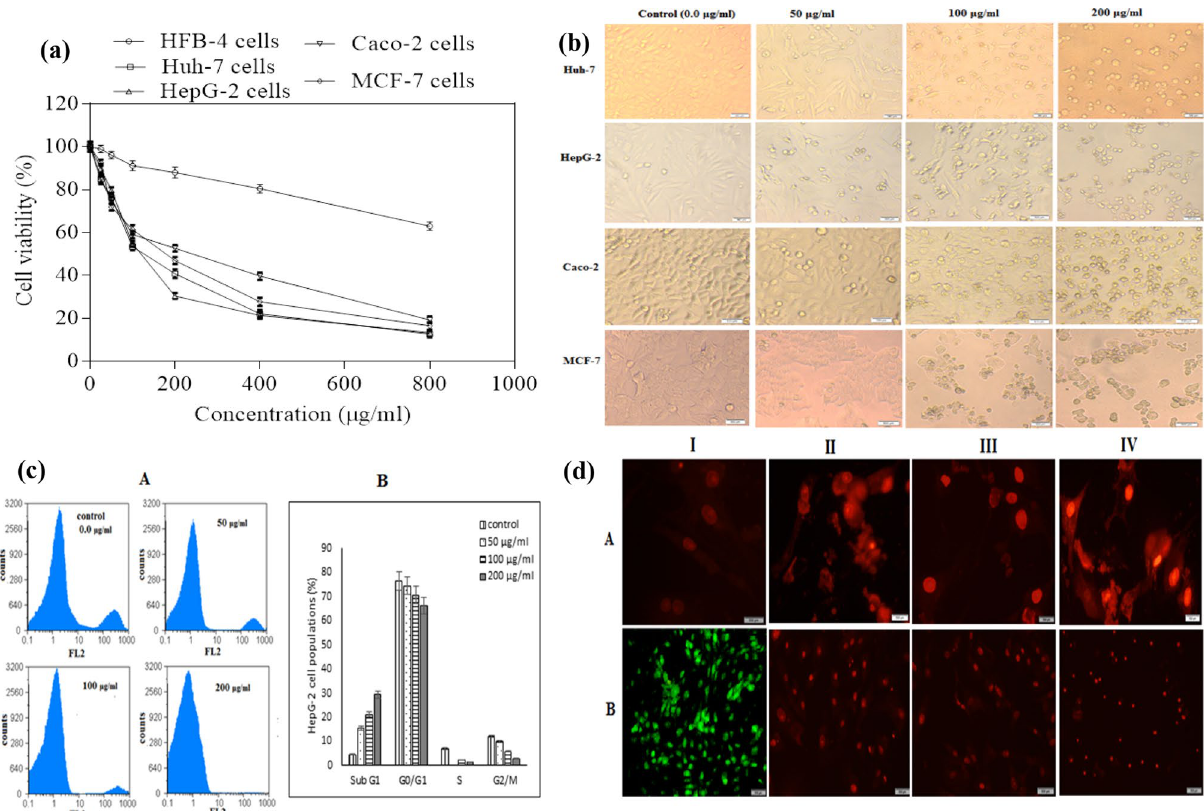
Figure 5. Effects of VGSE treatment at various concentrations for 48 h on ( a ) Cell viability, ( b ) Morphological modifications of cancer cells detected by an inverted phase-contrast microscope, ( c ) Cell cycle analysis in HepG-2 cells: (cA) Original flow charts of cell cycle distribution diagrams and (cB) Quantitative distribution of cell cycle distribution, and ( d ) Apoptosis using PI and double nuclear staining in HepG-2 cells (I, II, III, and IV correspond to concentrations of 0, 50, 100, and 200 μg/ml, respectively): (dA) Fluorescence images of PI staining and (dB) Fluorescence images of ethidium bromide-acridine orange staining. All values are expressed as mean ± SD, n = 3. Images were captured using Cell Quist (version 3.2) and Mod Fit (version 4.0)